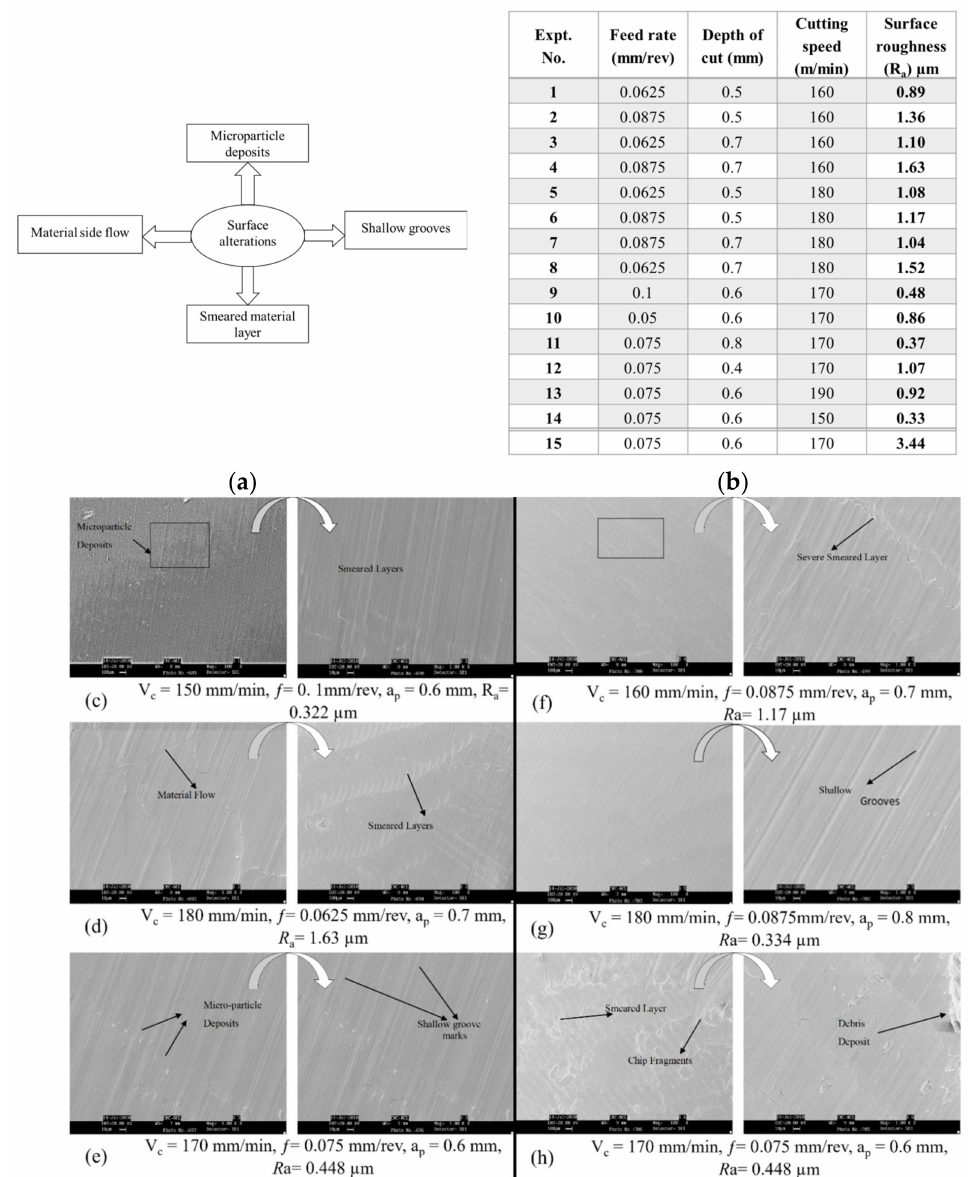
Figure 2. ( a ) Type of surface alterations observed and ( b ) process parameters and surface roughness for machining Ti6Al4V. ( c – h ) Demonstration of surface alterations due to machining of titanium (Ti-6Al-4V)